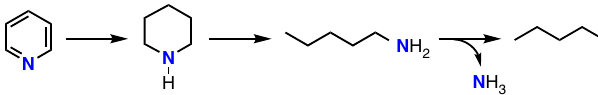
Fig. 1 Some key steps proposed for the HDN of pyridine on solid